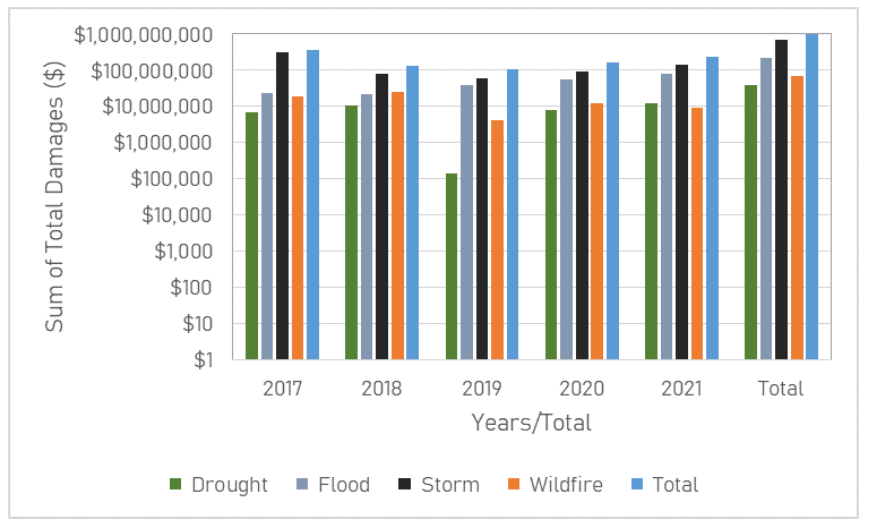
Figure 3. Sum of Total Damages for each hazard per year as reported by EM-DAT, heat wave cannot be seen as no damages are recorded (CRED, 2020).